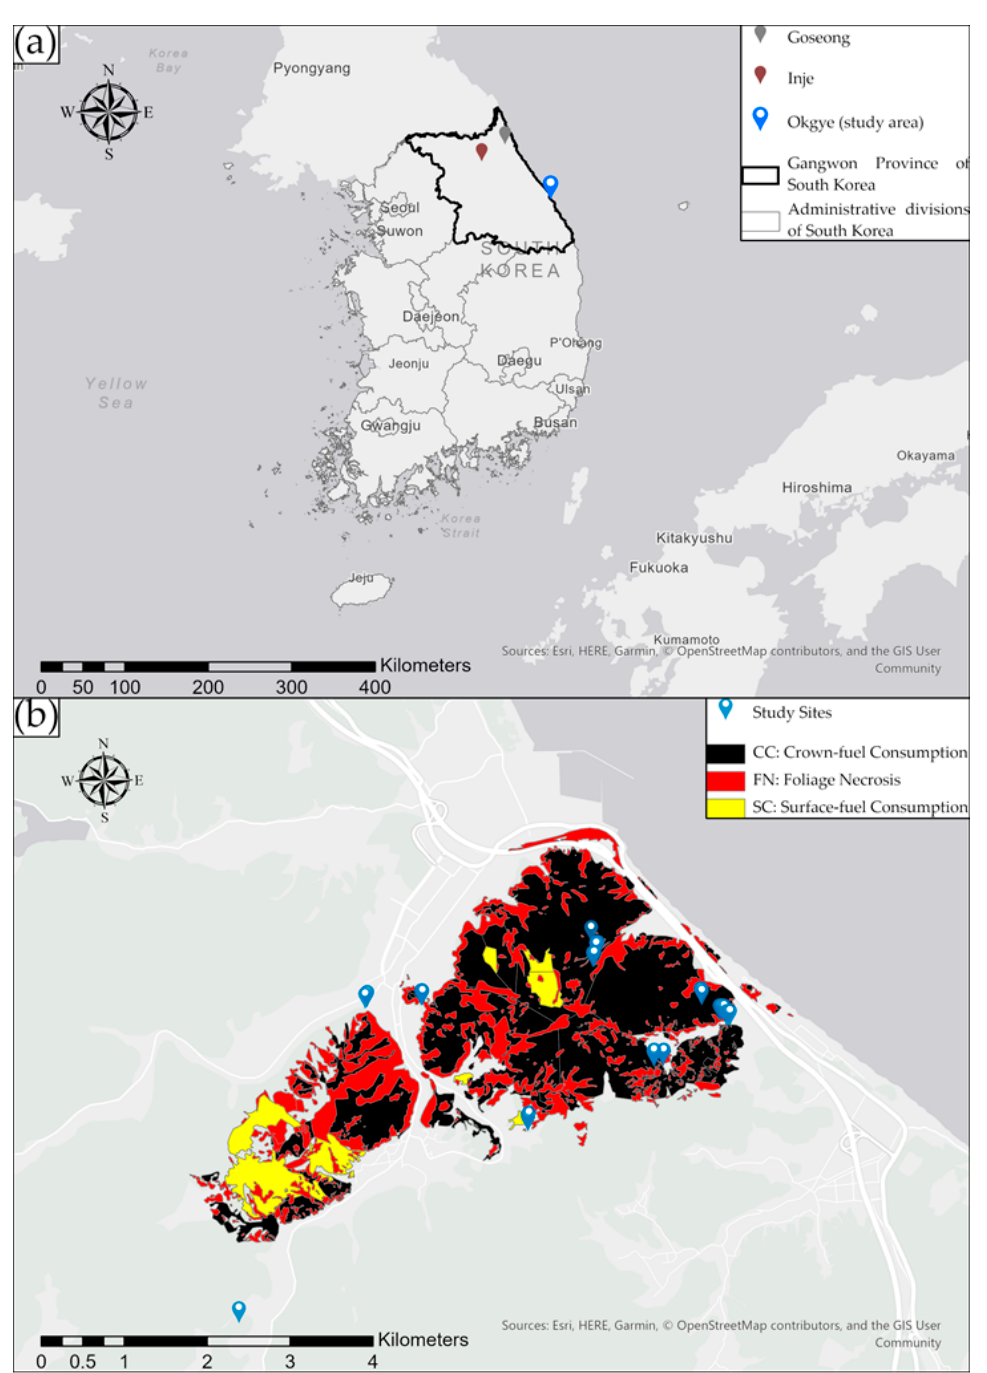
Figure 1. ( a ) Locations of Goseong, Inje, Okgye; ( b ) locations of 36 study sites on the vegetation burn severity map (provided by NIFoS, South Korea).